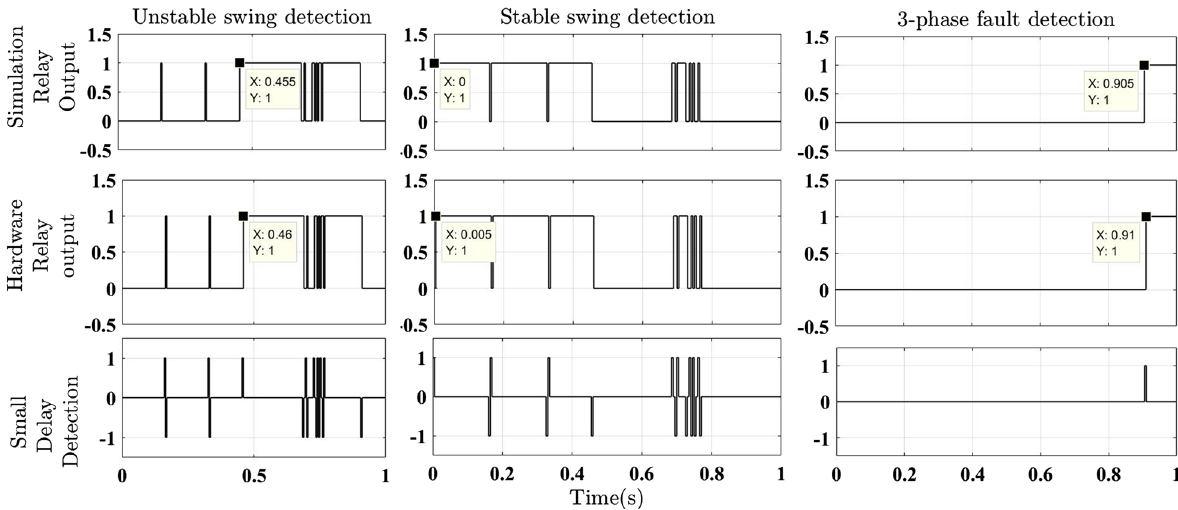
Fig. 10 Tripping signals of the hardware relay during HIL